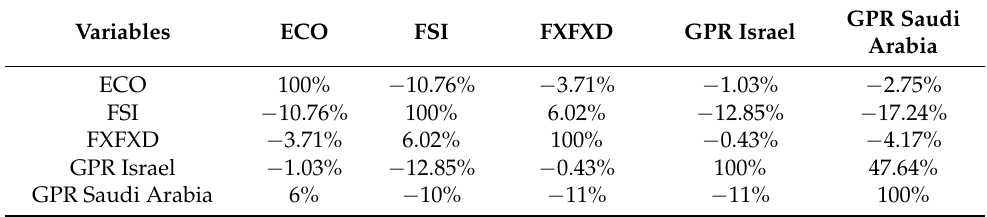
Table 2. Variable correlations.